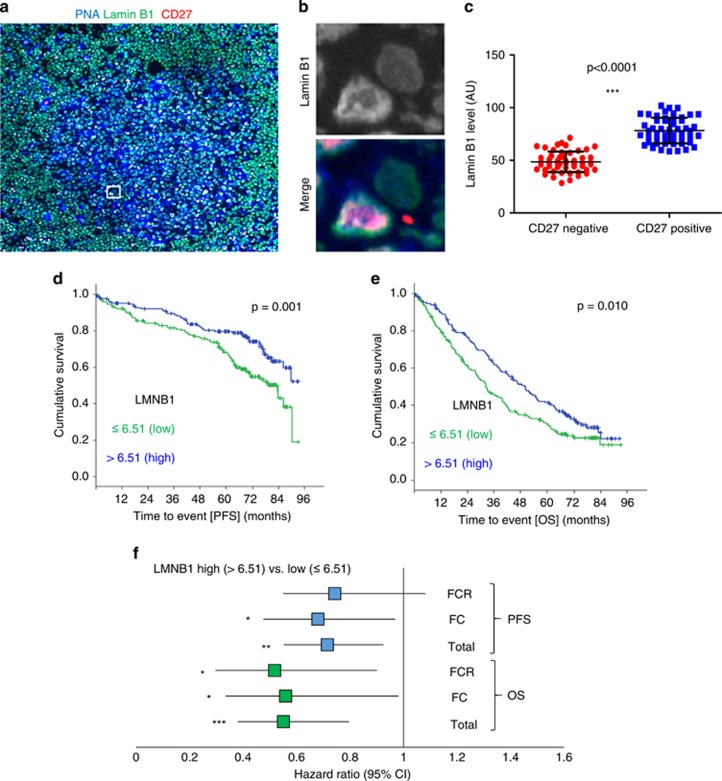
Nuclear Lamin B1 levels are restored in memory B cells and low LMNB1 expression level is an adverse prognostic factor in CLL. (a) Fresh frozen normal human lymph nodes were fixed in −20 °C methanol and then stained with PNA (blue), Lamin B1 (green) and anti-CD27 antibodies (red). (b) A zoomed in the area of (A, square) representing differential Lamin B1 expression in CD27+ vs CD27- cell. (c) High-throughput comparison of Lamin B1 levels in CD27+ and CD27- GC cells. Lymph nodes from three patients were assessed and in total 50 randomly selected CD27+, and 50 randomly selected CD27- GC cells were analysed using MetaMorph software. (d, e) showing Kaplan–Meier estimates of progression-free (PFS) (d) and overall (OS) (e) of CLL patients enrolled on the CLL8-trial as a factor of LMNB1 expression, dichotomised by the median (>6.51, N=168 and ⩽6.51, N=169. (f) Univariate Cox regression analysis comparing low (⩽6.51, N=169) and high (>6.51, N=168) LMNB1 expressing CLL patients as a factor of the treatment regime (FC or FCR) applied. *P<0.05, **P<0.01, ***P<0.001.